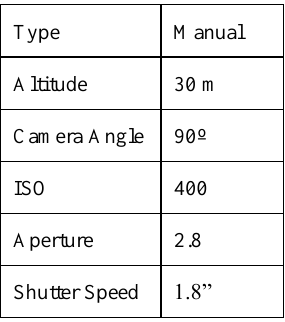
Table 1. Flight acquisition plan and camera parameters used in UAS survey.